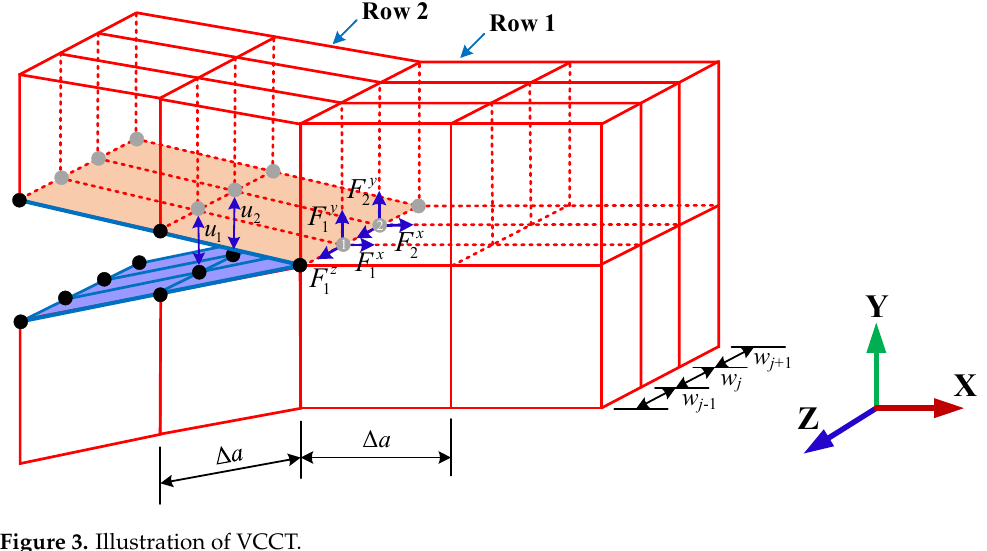
Figure 3. Illustration of VCCT.